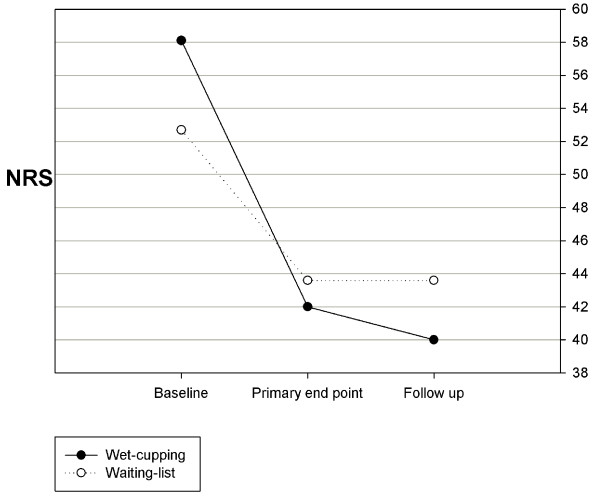
The change in the numeric rating scale (NRS) of pain.